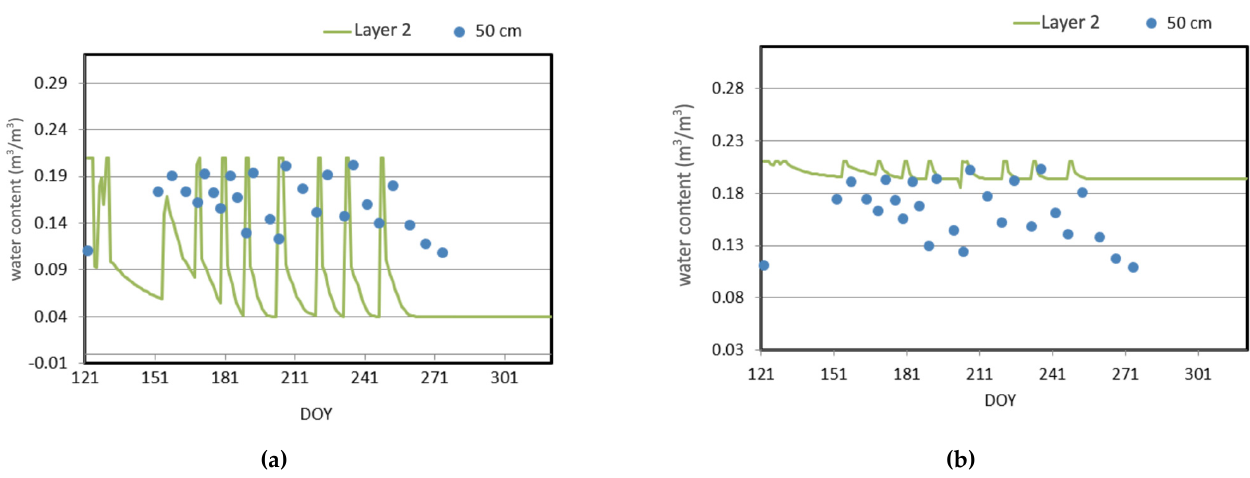
Figure 10. Sensitivity analysis of FT2 plot. ( a ) Neutron readings and daily simulated soil water content in layer 2. ( b ) Neutron readings and daily simulated soil water content in layer 2 using tipping bucket parameters for clay.